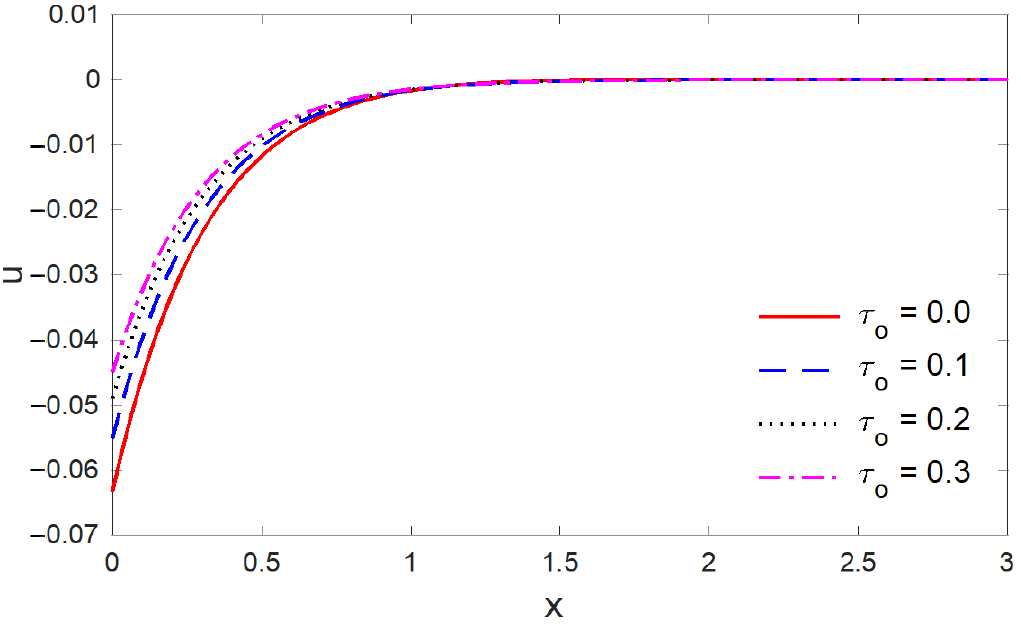
Figure 5. The displacement variations via the distance for different values of τ o under (NLTEM).